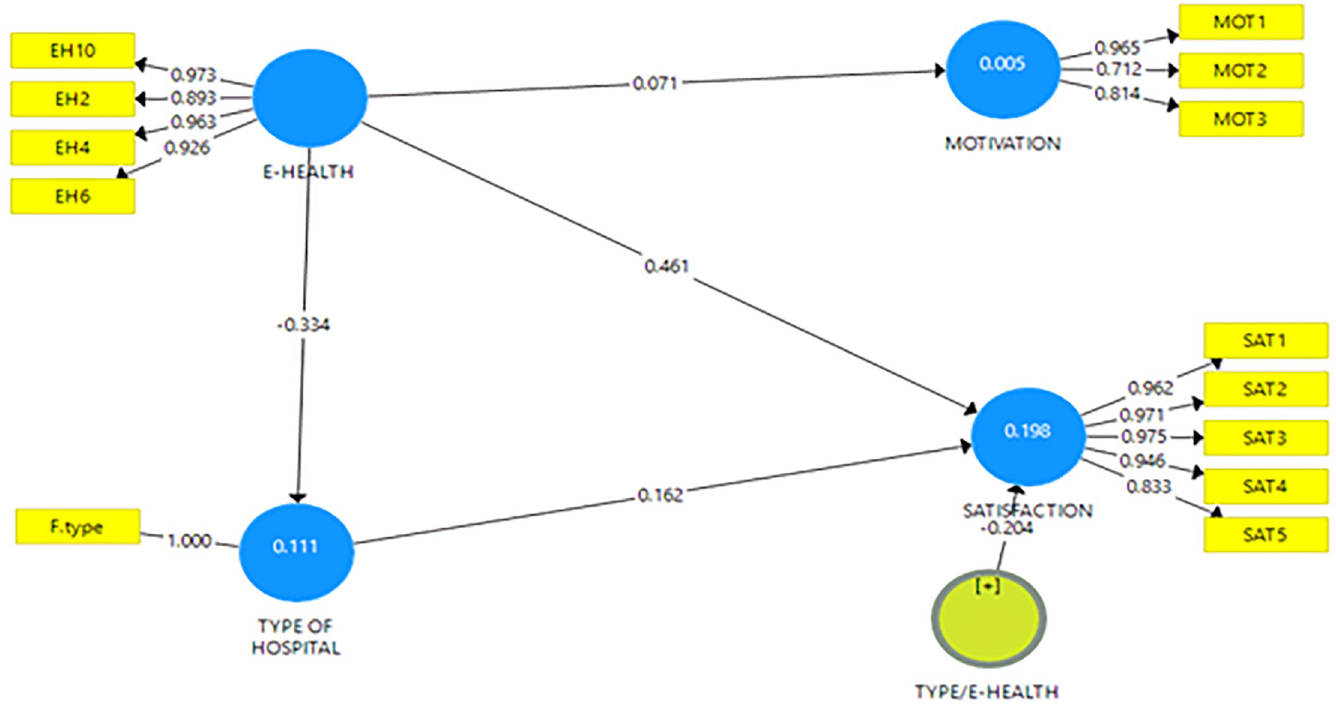
Fig 1. Tests statistics and path